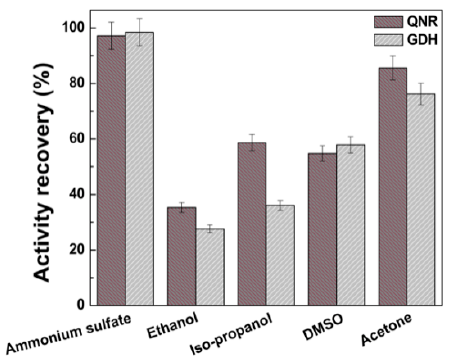
Figure 5. Effect of precipitants on activity recovery of the magnetic combi-CLEAs. The measurements were performed in triplicate.